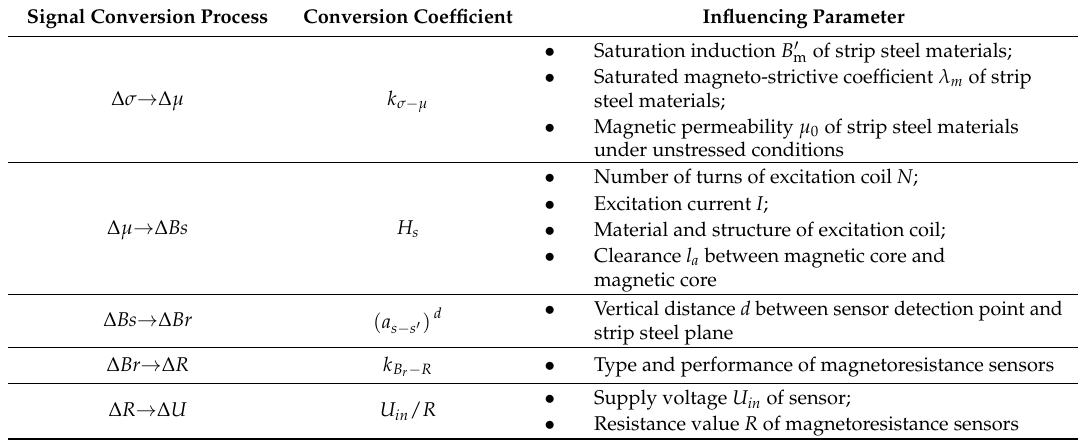
Table 1. Signal conversion coefficient and influential parameters.